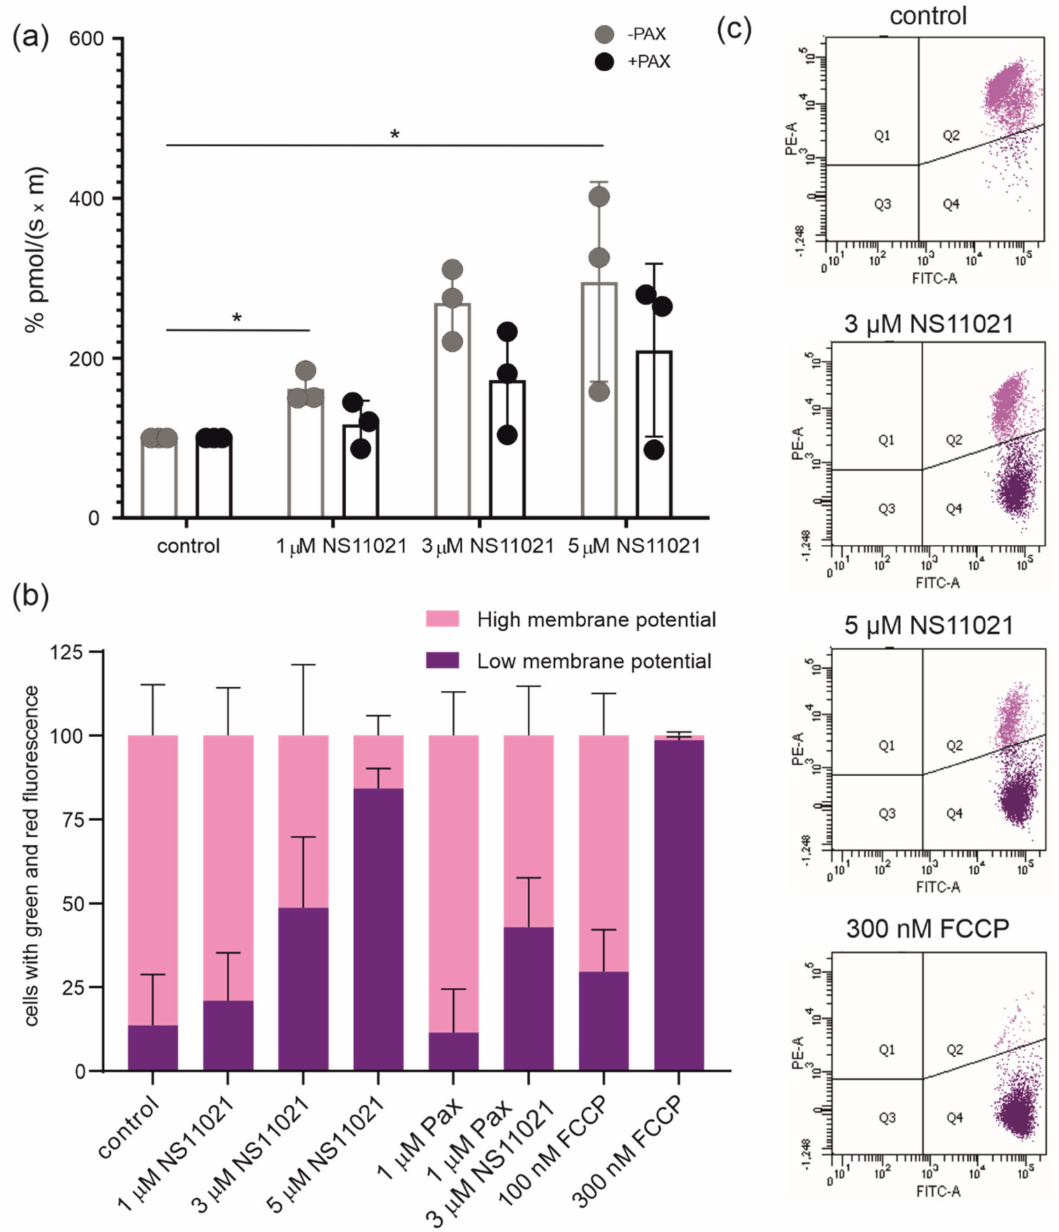
Figure 7. Effects of mitoBK Ca channel modulators on the membrane potential and respiration rate. ( a ) Mitochondrial respiratory capacity; a final density of 1.5 × 10 6 cells/mL was plated in each chamber and the NS-induced changes in respiratory rate in the presence ( • ) or absence ( • ) of 10 µ M paxilline were detected. Data are reported as the means ± SD ( n = 3), and each dot represents a separate experiment. ( b ) Measurement of the mitochondrial membrane potential using the JC-10 dye. Changes in red vs. green fluorescence were used to measure the mitochondrial membrane potential after treatment of 16HBE14o- cells with BK Ca channel modulators. FCCP-treated cells were used as positive controls. ( c ) Representative dot plots of stained 16HBE14o- cells obtained using a flow cytometry analysis. Cells that appear in quadrant 4 represent cells with depolarized mitochondrial membranes. p < 0.05